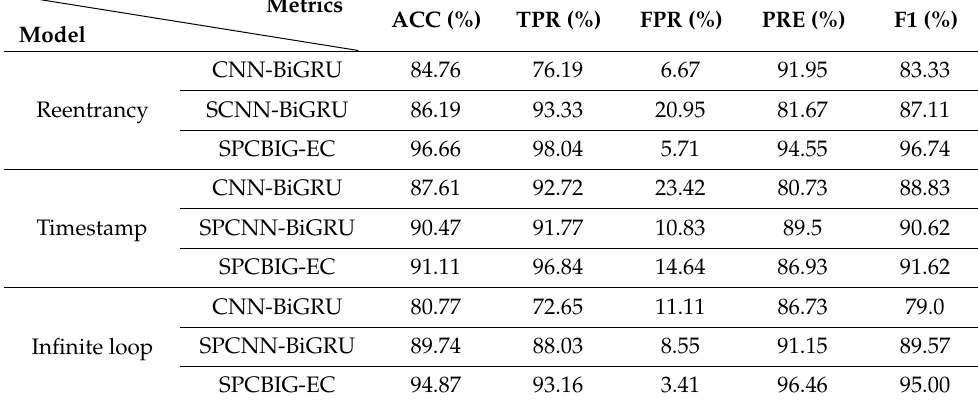
Table 6. The results of the detection of hybrid vulnerabilities with the SCR Detection